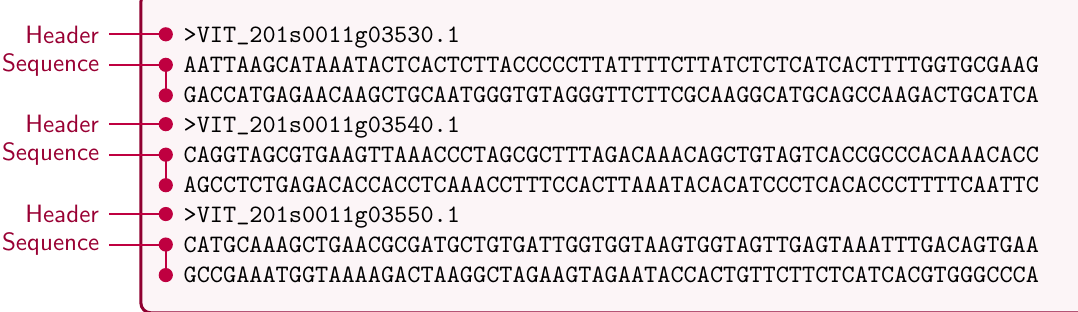
Figure 1. A sample of the Multi-FASTA